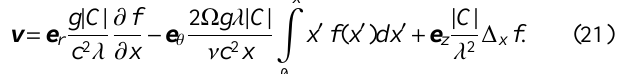
Figure 4. Profile of dimentionless potential field f ( x ) with rotation. The values of parameters are the same as the non-rotational case, except the Coriolis parameter Ω= 0 . 23s − 1 .